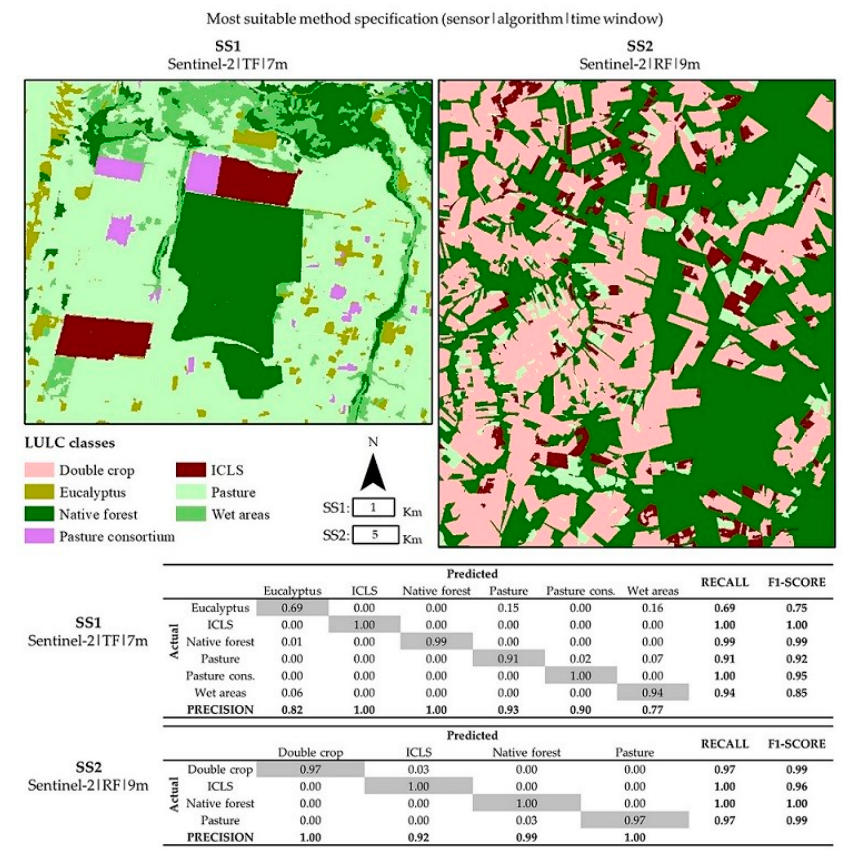
Figure 4. More suitable method specifications for ICLS (sensor, algorithm, and time window) for each study site, confusion matrices, and the respective values of precision, recall, and the F1 score for all classes.